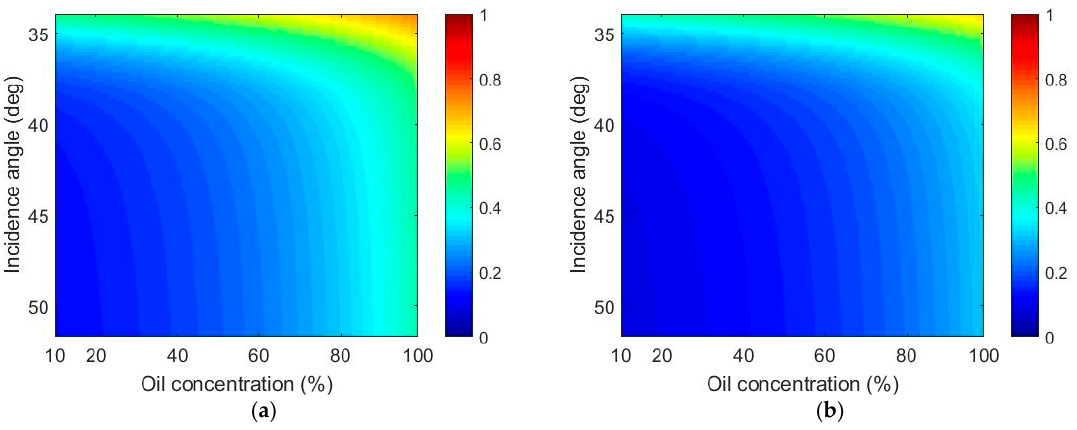
Figure 10. Reference map of PR values at L-band estimated with ( a ) the U-WCA scattering model and ( b ) the Bragg theory.